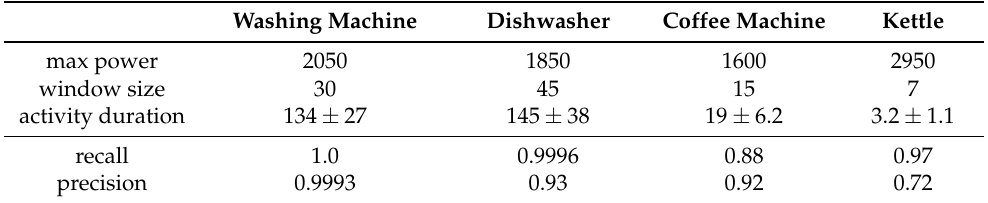
Table 1. Statistics and results of appliance detection. The window size and activity duration are listed in